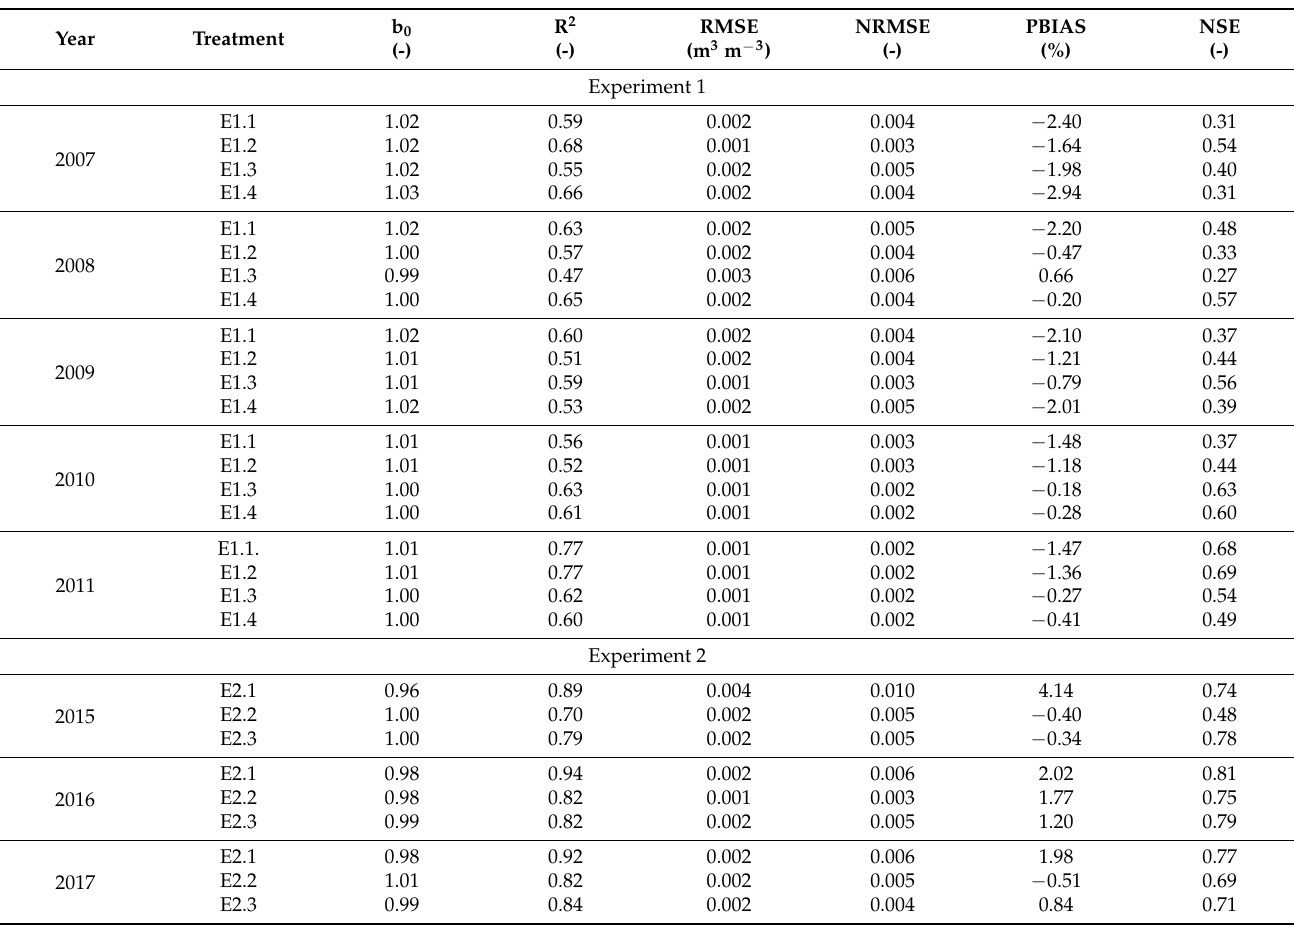
Table 10. Goodness-of-fit indicators for the adjustment between measured and simulated soil water content values using the A&P